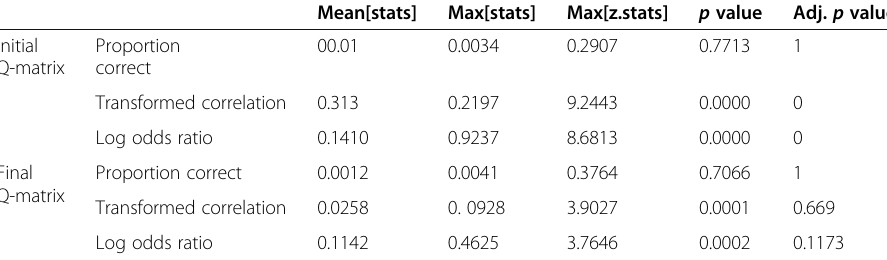
Table 2 Item-level fit indices for initial and final Q-matrices